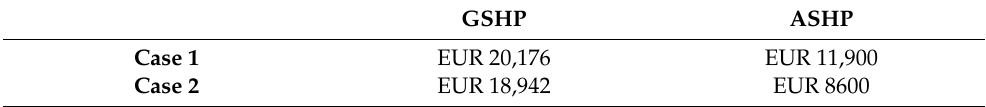
Table 9. Initial investment associated with each study case in each of the heat pump systems evaluated in this research.